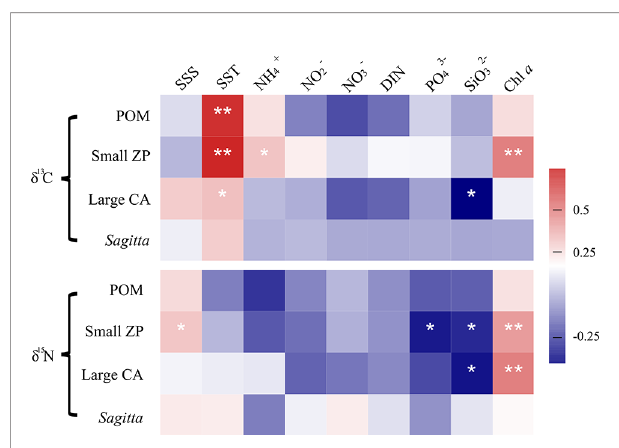
FIGURE 7 | Correlation coef fi cients between stable isotopes ( d 13 C and d 15 N) and key environmental parameters in Jiaozhou Bay. * p < 0.05, ** p <